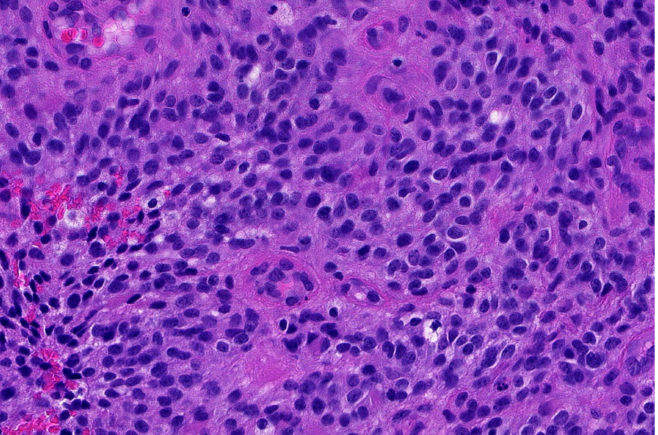
Figure 3. Higher magnification shows more irregular nuclei of the EWSR1 -PATZ sarcoma in compar- ison to Ewing sarcoma (HE; 40 ×